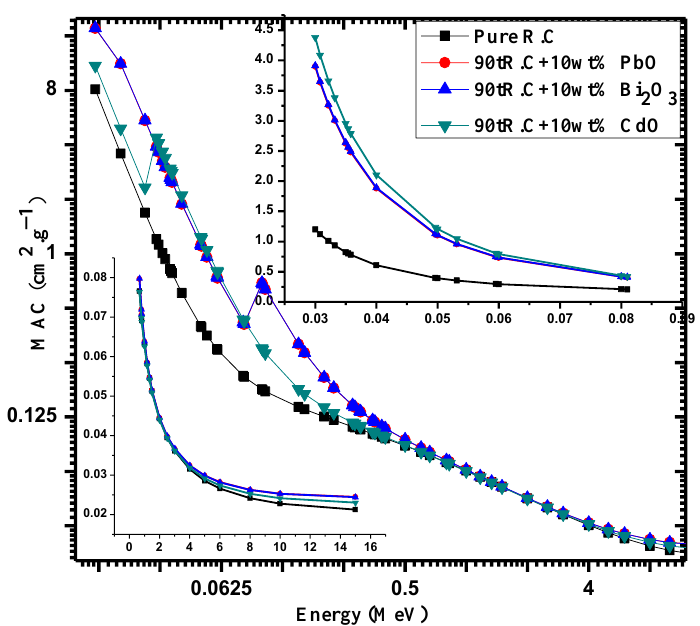
Figure 2. The MAC as a function of energy ranging from 0.015–15 MeV for different micro-samples calculated by XCOM software.